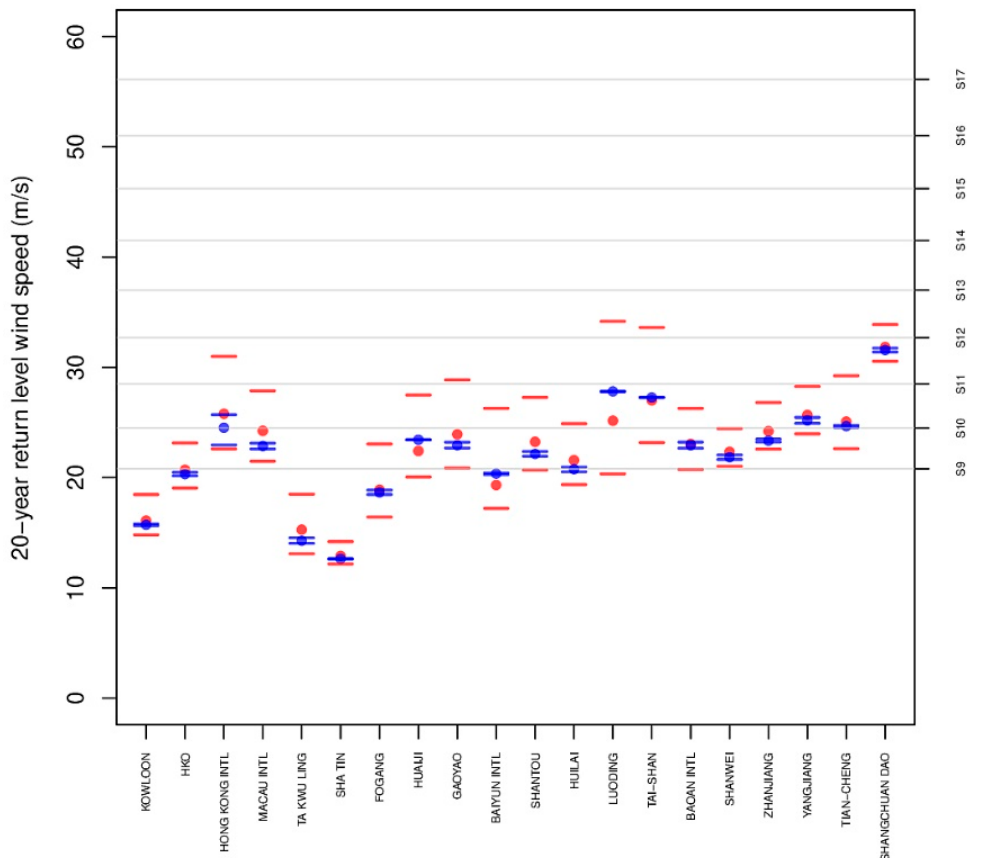
Figure 4. 20-year return level of selected stations in Guangdong, Hong Kong, and Macau, calculated from historical observations (red) and the TOT event set (blue). Bars and dots indicate the 95% confidence interval and estimates, respectively. Vertical axis on the right shows the corresponding category in the extended Beaufort wind scale.